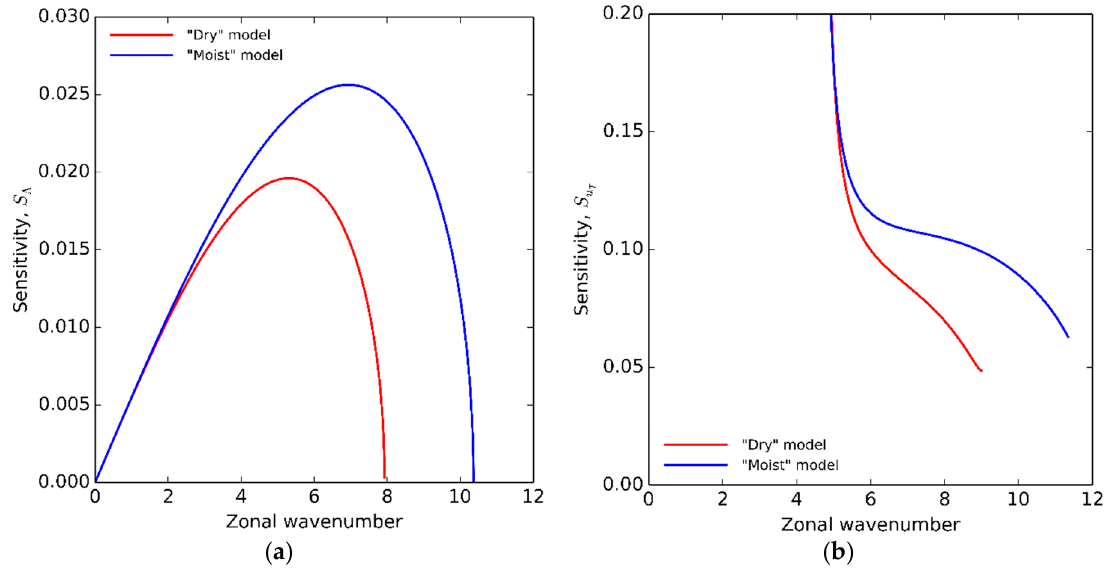
Figure 3. Sensitivity functions with respect to the meridional temperature gradient (MTG) parameter versus zonal wavenumbers for the “dry” and “moist” ( a ) f -plane and ( b ) β -plane models.